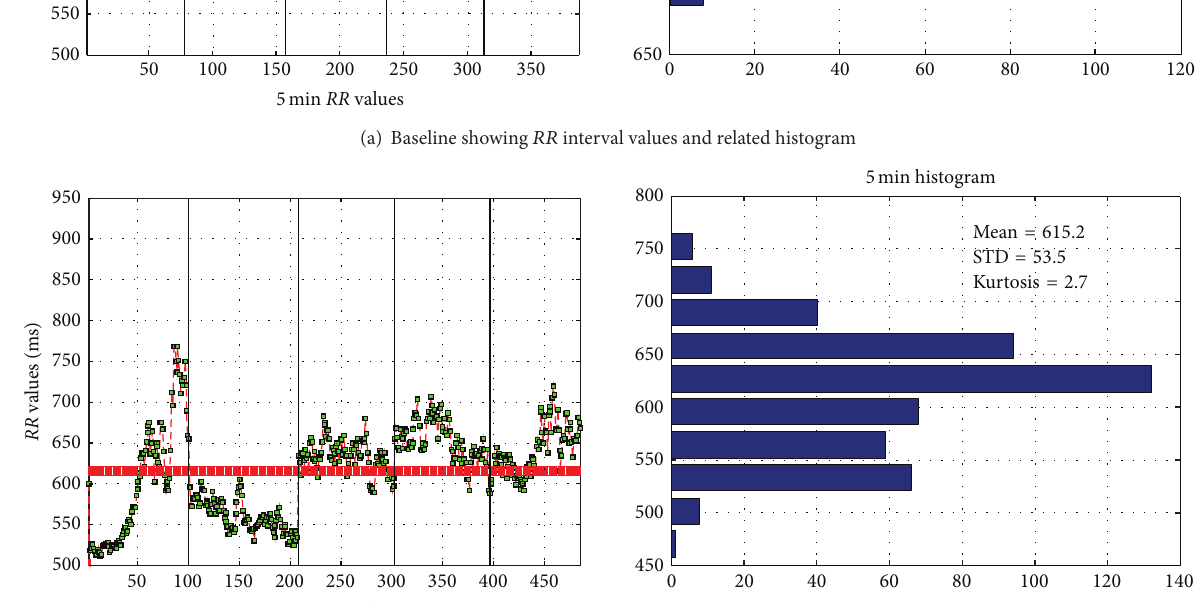
(b) Active phase during rTMS stimulation showing 𝑅𝑅 intervals and related histogram Figure 5: 𝑅𝑅 interval and related histograms comparing (a) baseline to (b) active